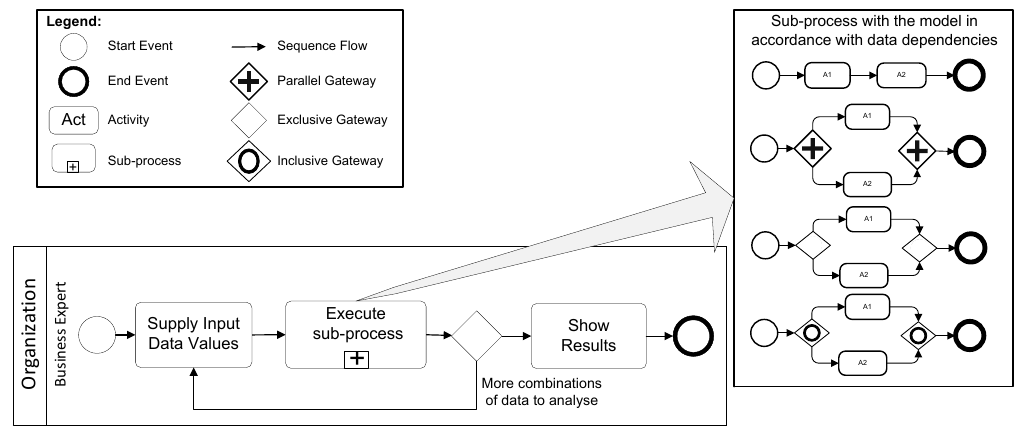
Figure 4. Imperative Representation of the Declarative Model.